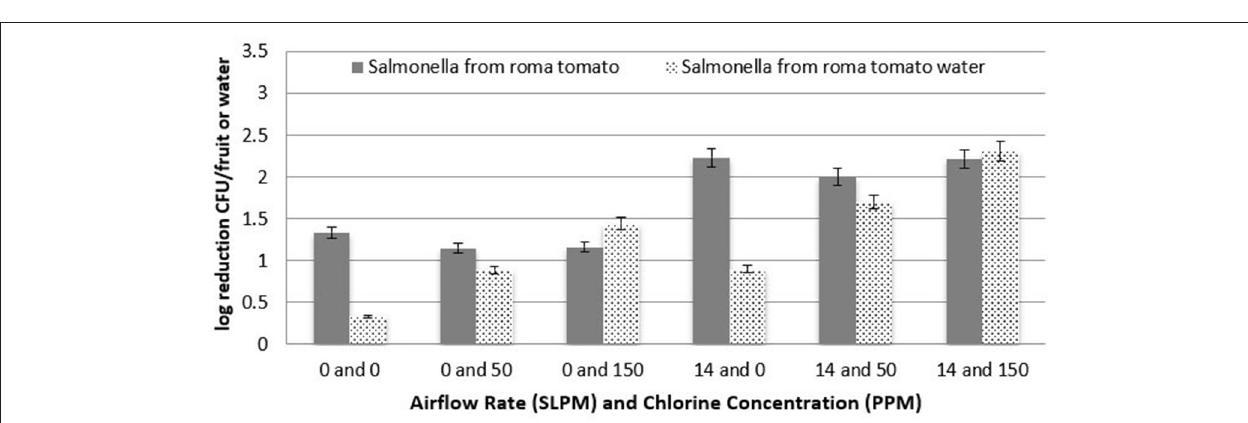
FIGURE 7 | Log reduction of Salmonella on Roma tomatoes as a function of airflow rate and chlorine concentration ( n = 6).